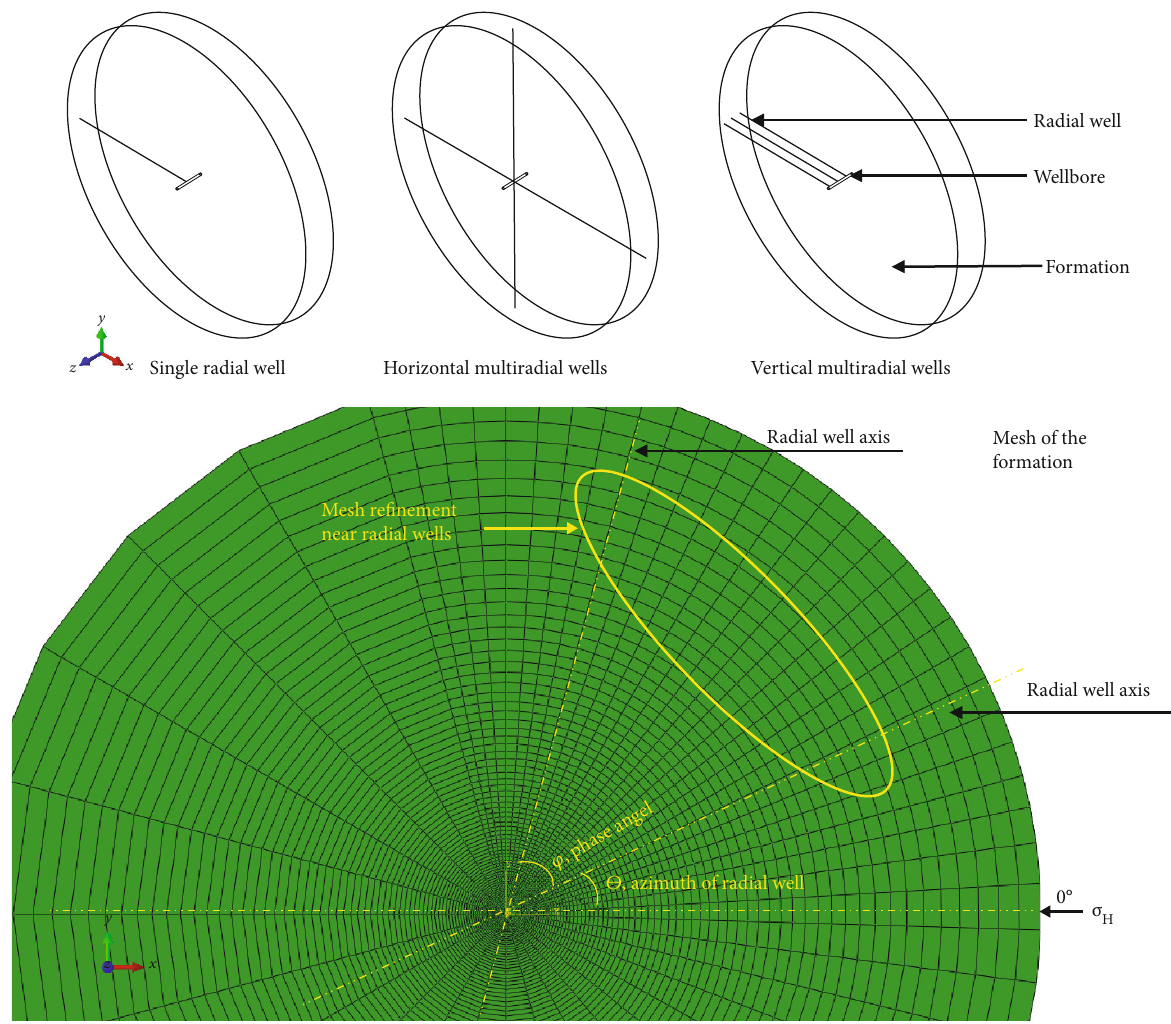
Figure 1: Sketch of a model. Table 1: Table of hydraulic fracturing model